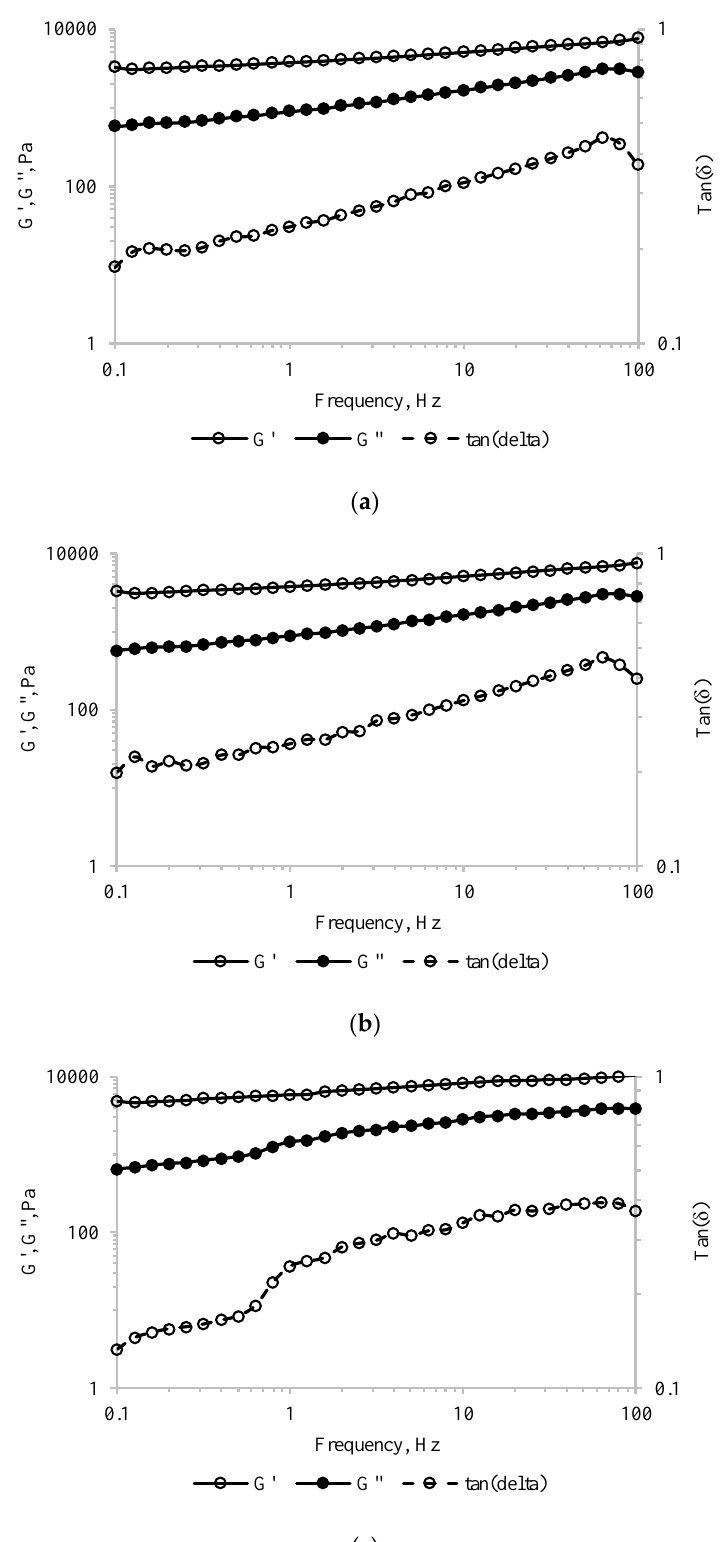
Figure 4. Storage modulus ( G ′), loss modulus ( G ″), and tan(δ) values of the pastry cream sample supplemented with different amounts of MBC: ( a ) Control—0% MBC, ( b ) 5% MBC, ( c ) 10% MBC.